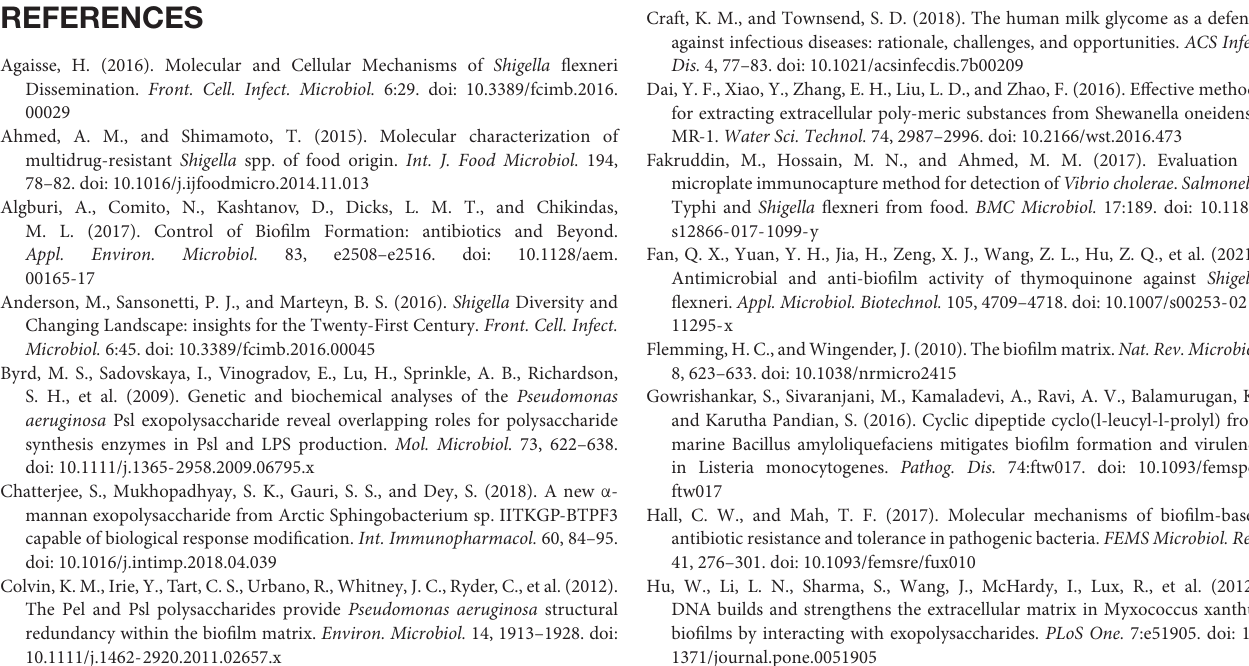
Supplementary Figure 1 | Standard curve of molecular weight